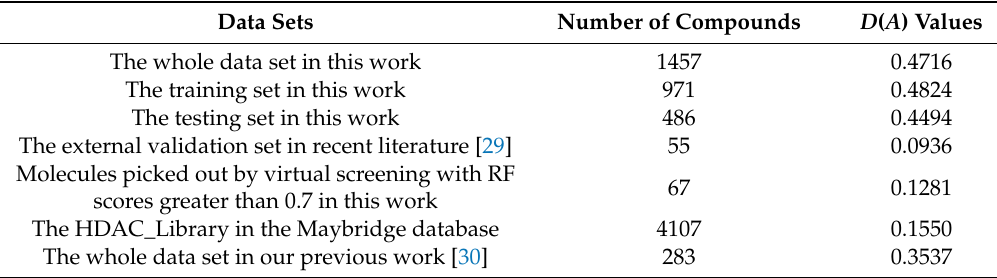
Table 1. The D ( A ) values of compounds in several data